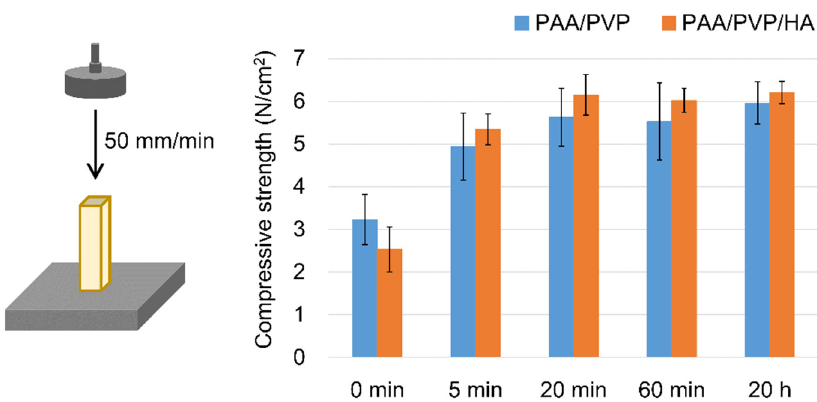
Figure 2. Measurement of shear adhesion strength of the PAA/PVP sponges or films. Significance in difference between two groups was tested by Student t -test. (mean ± SD, * p < 0.05, ** p < 0.01).